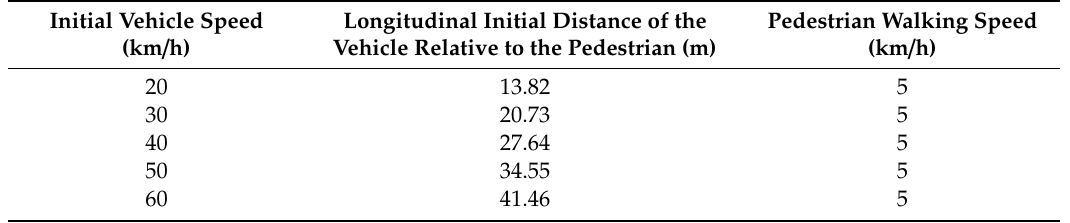
Table 13. The CVNA (Car-to-VRU Farside Adult)-75 simulation conditions. Initial Vehicle